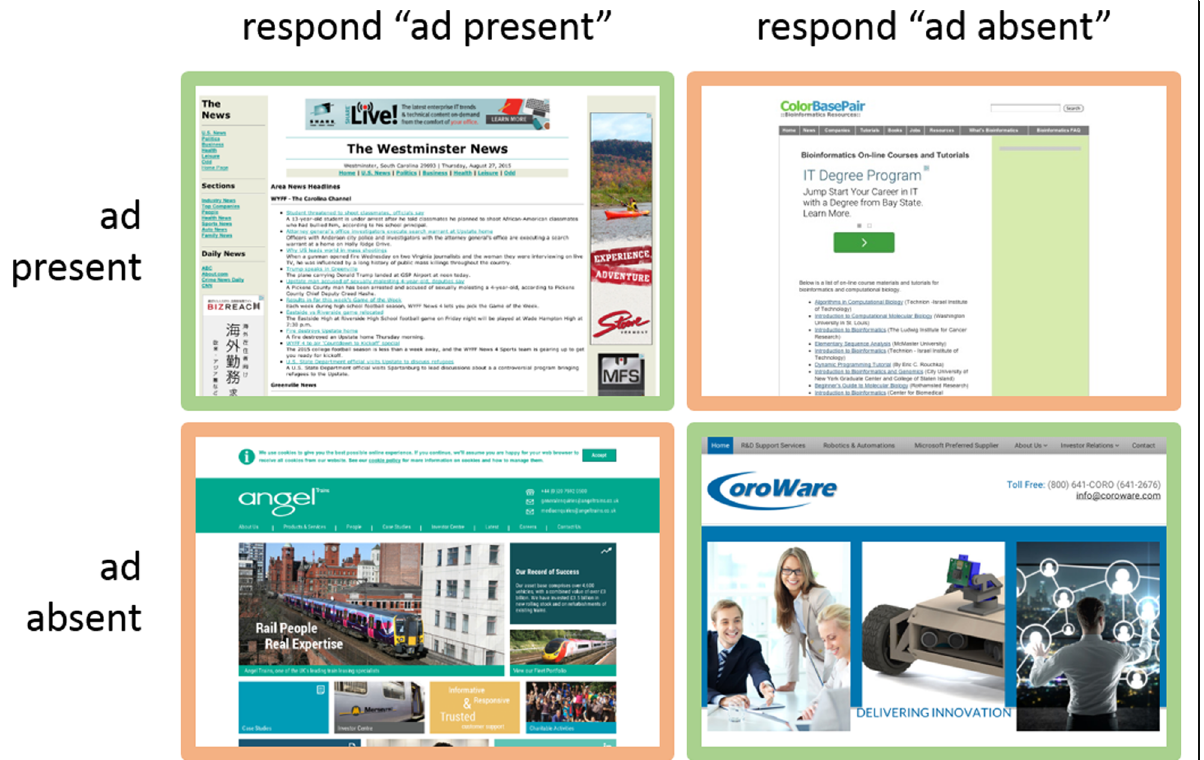
Fig. 8 Examples of ad-detection stimuli. The top row web pages have an ad while on the second row web pages do not. The first column denotes web pages for which observers overwhelmingly responded “ ad present, ” while the second denotes predominantly “ ad absent ” responses. Therefore, the green outline indicates largely correct responses while orange indicates mostly incorrect